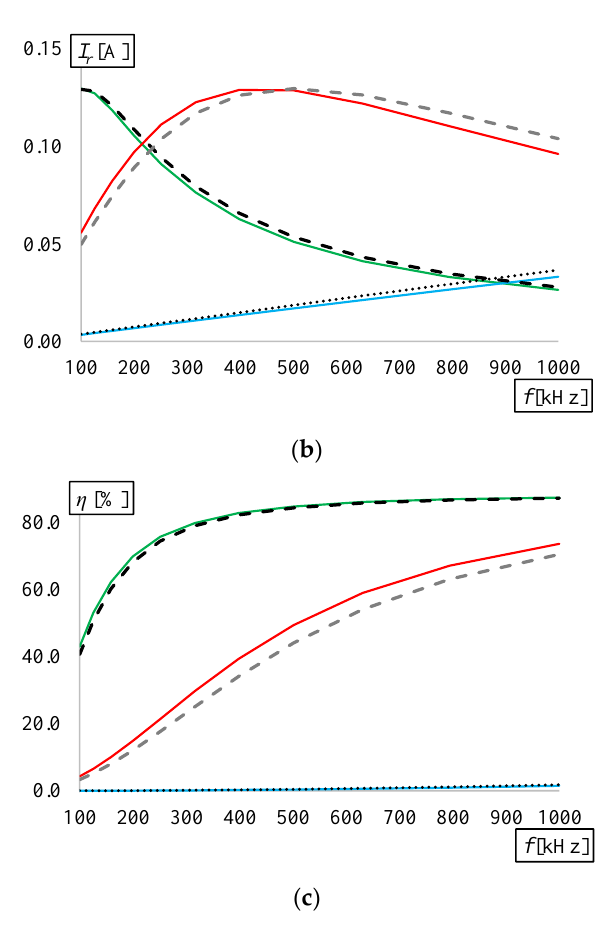
Figure 11. Results for the case r c = 20 mm, n c = 70: ( a ) transmitter current, ( b ) receiver current, and ( c ) power transfer efficiency.